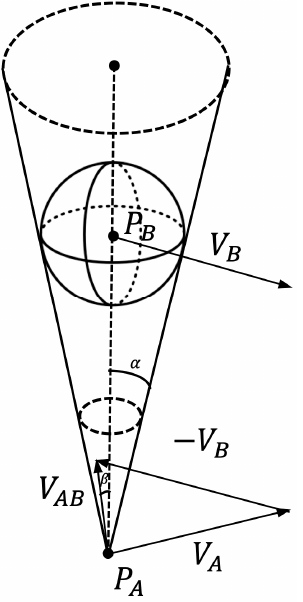
Figure 9. Schematic diagram of 3D dynamic obstacle method.